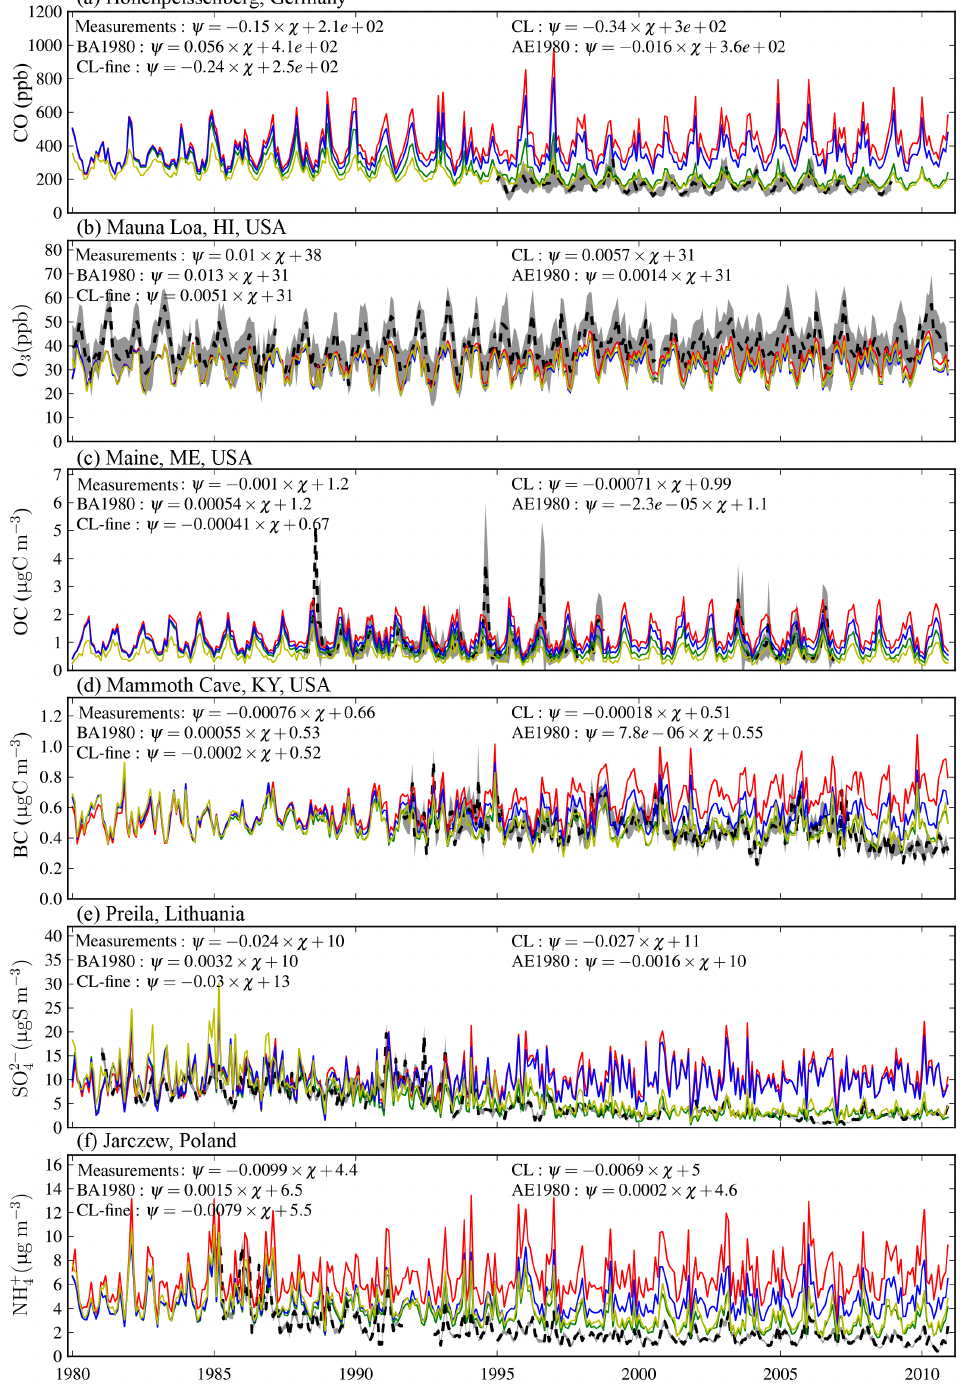
Figure 2. Comparison of the four simulations against observations. The dashed line and shadowed areas indicate monthly mean surface observations and 1 standard deviation. Simulations: CL is current legislation (green); CL-fine is current legislation in the fine resolution of the model; BA1980 is Business As in 1980, with constant anthropogenic emission rates per capita as in 1980 (red); AE1980 is constant anthropogenic emissions as in 1980 (blue). Trends derived from the concentrations ( ψ ) as a function of the year ( χ ) are provided for the measurements and the four simulations inside the